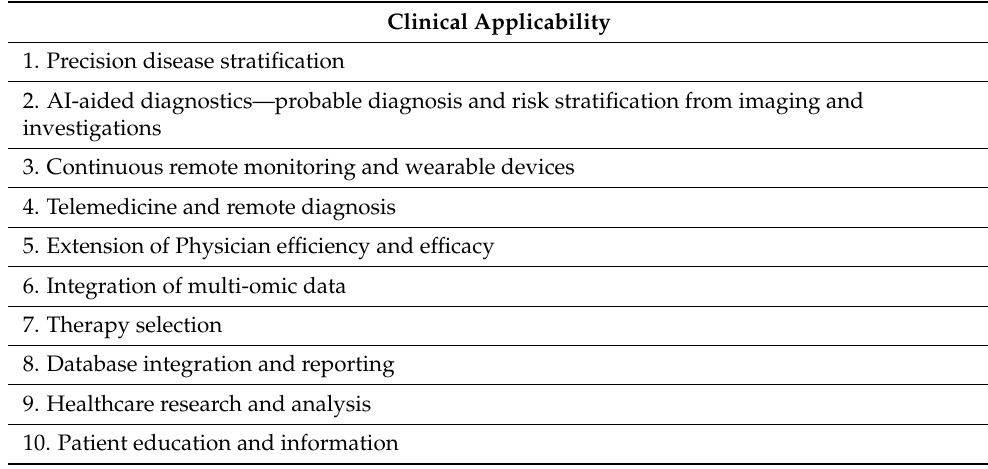
Table 5. Clinical applicability of artificial intelligence in precision cardiology